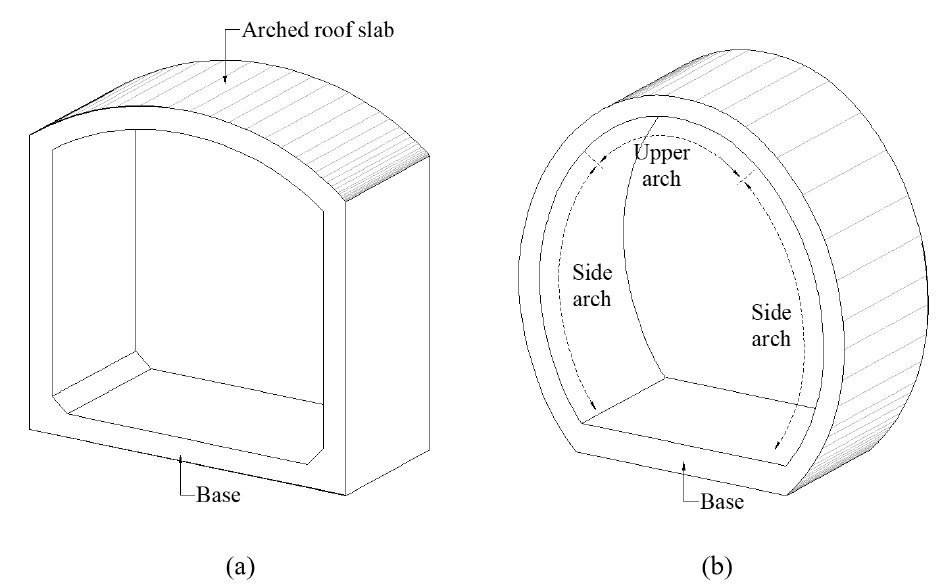
Figure 1. Cross section of the proposed